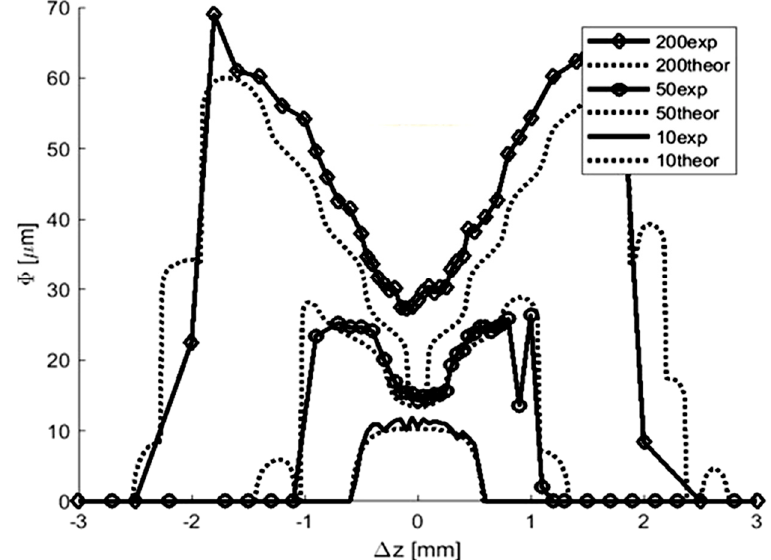
Figure 8. Diameter ϕ ( µ m) of the crater drilled in a function of distance ∆ z (mm) of the exposed surface from the focal plane. Curves with exp marking in the legend concern the experiment, point curves with theor marking concern the calculations. A number at the beginning of the curve name denotes the energy of the pulse ( µ J). The laser fluence of each curve is ca. 3.5 J · cm − 2 .